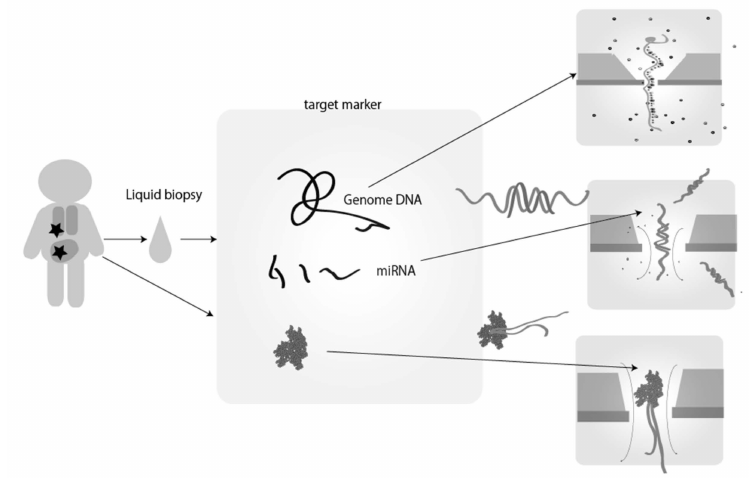
Figure 4. Cancer diagnosis by single-molecule electrical detection of cancer marker molecules and counting of miRNA molecules. Tumor-specific marker molecules in liquid biopsy samples, such as blood, urine, and saliva obtained from patients, are measured. After these samples are pretreated by purification, amplification, and chemical treatment, single-molecule measurements are performed using nanodevices to distinguish between patients and healthy individuals. There are several reports of the detection of genes and miRNAs by sequencing, and/or detection using probe molecules that selectively bind to the target.